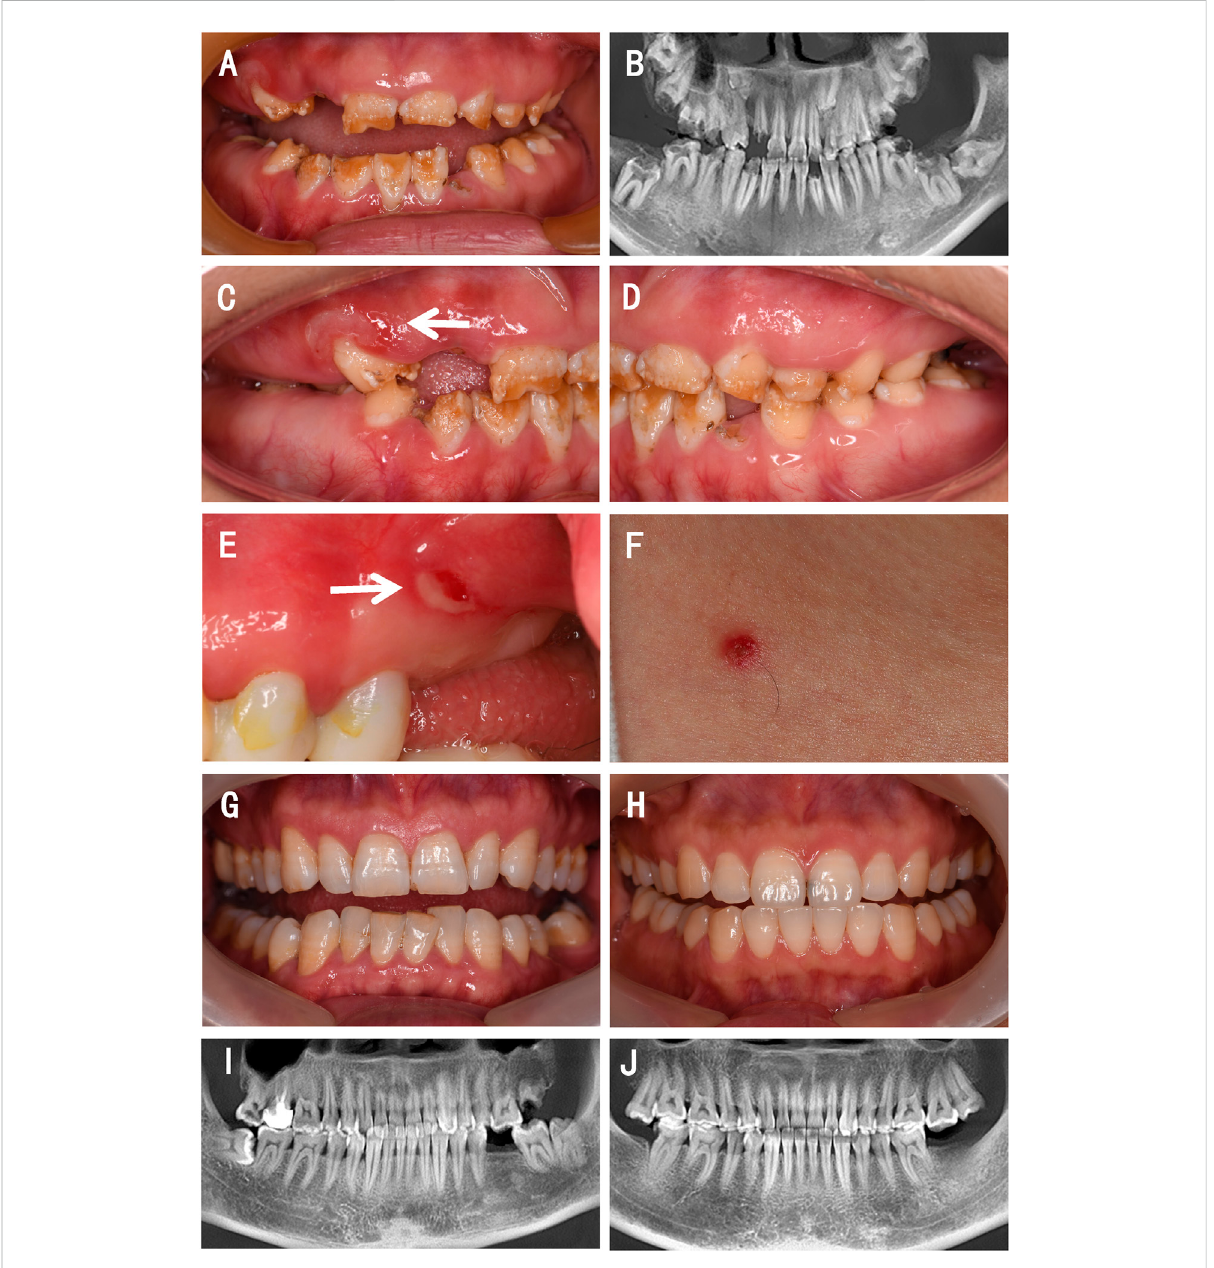
FIGURE 1 Clinical presentations and radiographic fi ndings of a family with a proband presenting with JEB. (A,C – E) Intraoral photographs of the proband. (B) Reconstructed panoramic view of the proband ’ s dentition. (F) Photograph of the skin of the proband. (G) Intraoral photograph of the proband ’